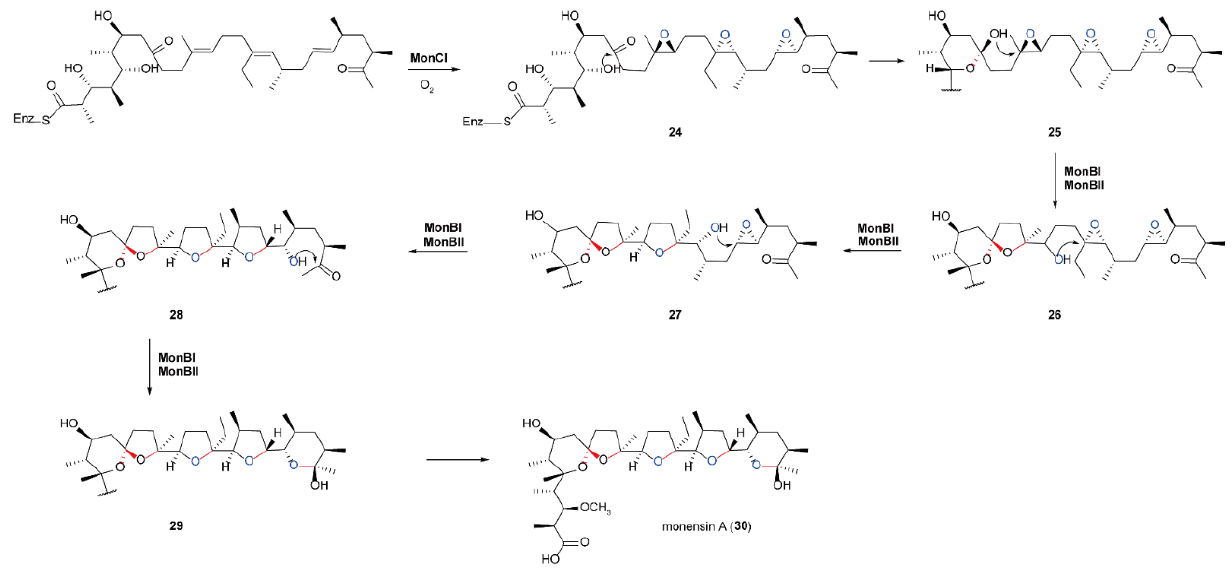
Scheme 9 . Mechanism of polyether formation during Monensin biosynthesis involving